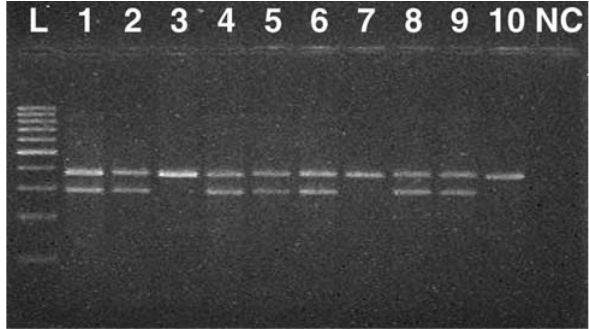
Figure 1 - Molecular discrimination of Harpia harpyja specimens of known and unknown sex. Individuals 3 and 4 are male and female, respec- tively. Females show two bands separated by approximately 100 bp while males show only a single band. The size standard (L) is the